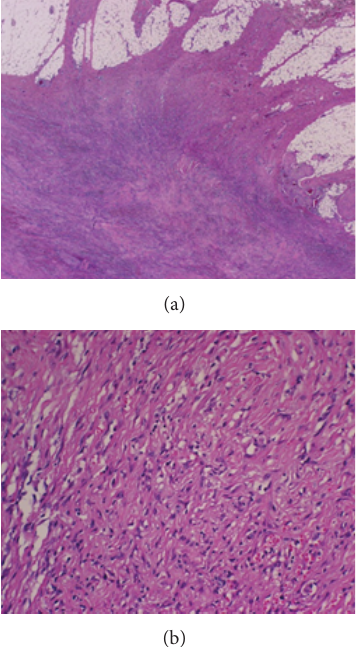
Figure 4: Hematoxylin and eosin staining shows the typical features of nodular fasciitis: (a) × 2 and (b) ×